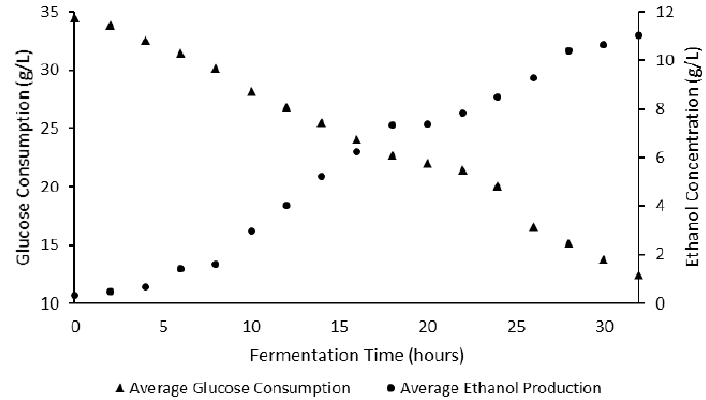
Fermentation 2017 , 3 , 19 Figure 3. Average glucose utilisation and ethanol formation during batch fermentation by S. cerevisiae BY4743.